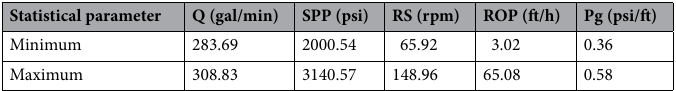
Table 6. Values used for data normalization.